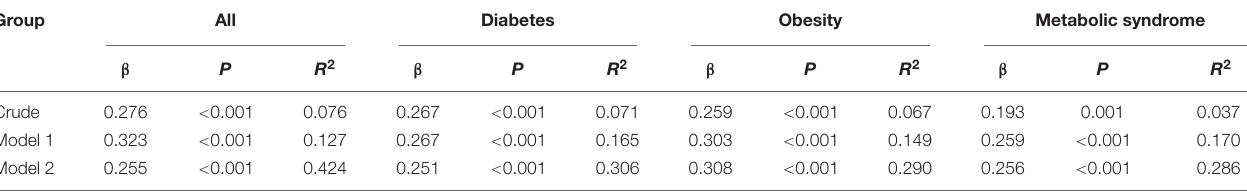
Univariate (Crude model) and multivariate stepwise linear regression analysis showing associations between serum FABP4 and FLI in the whole population (All), diabetes, obesity and metabolic syndrome patients. FLI was entered as a dependent variable and FABP4, age, gender (Model 1) and FABP4, age, gender, glucose, triglycerides,